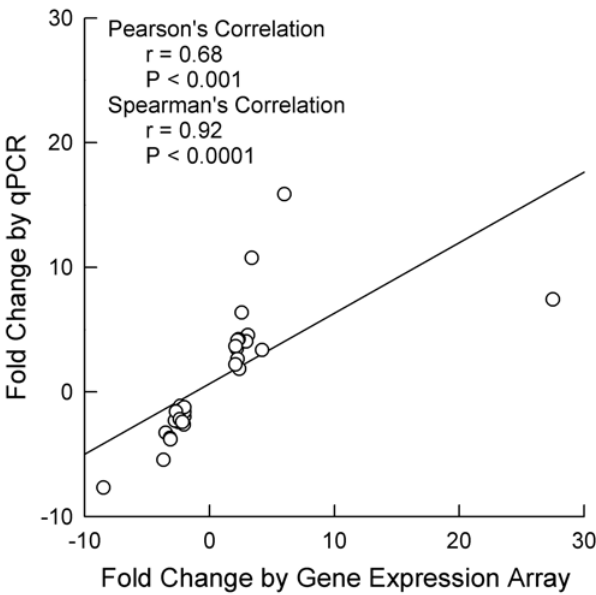
Figure 1. Relationship between fold changes in gene expres- sion by expression array versus qPCR. Correlation coefficients are indicated for both Pearson’s and Spearman’s correlation methods.